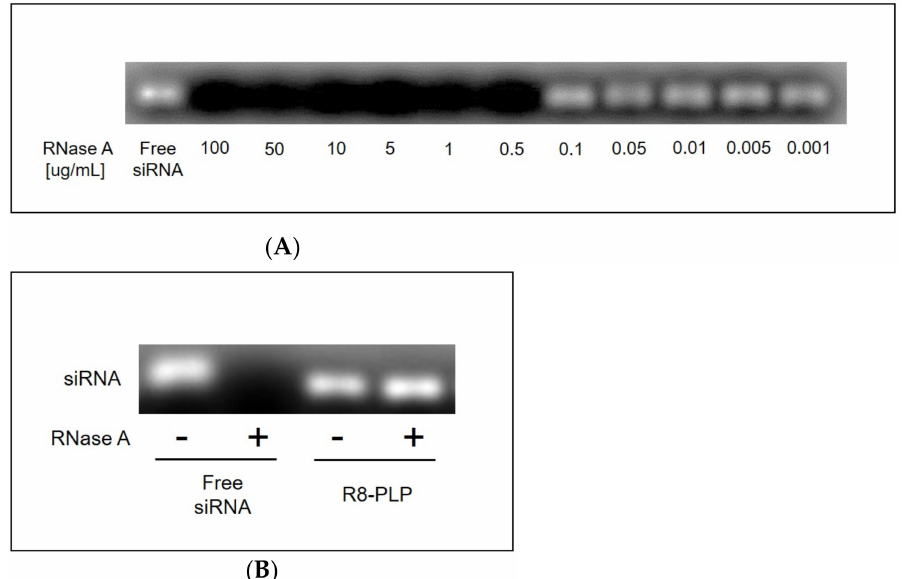
Figure 6. (A ) Assay development indicated treatment with 0.5 ug/mL RNase A enzyme was the minimum concentration sufficient for complete siRNA degradation. ( B ) RNase stability assays indicated that R8-PLP nanoparticles sufficiently protected encapsulated and complexed siRNA when exposed to nuclease